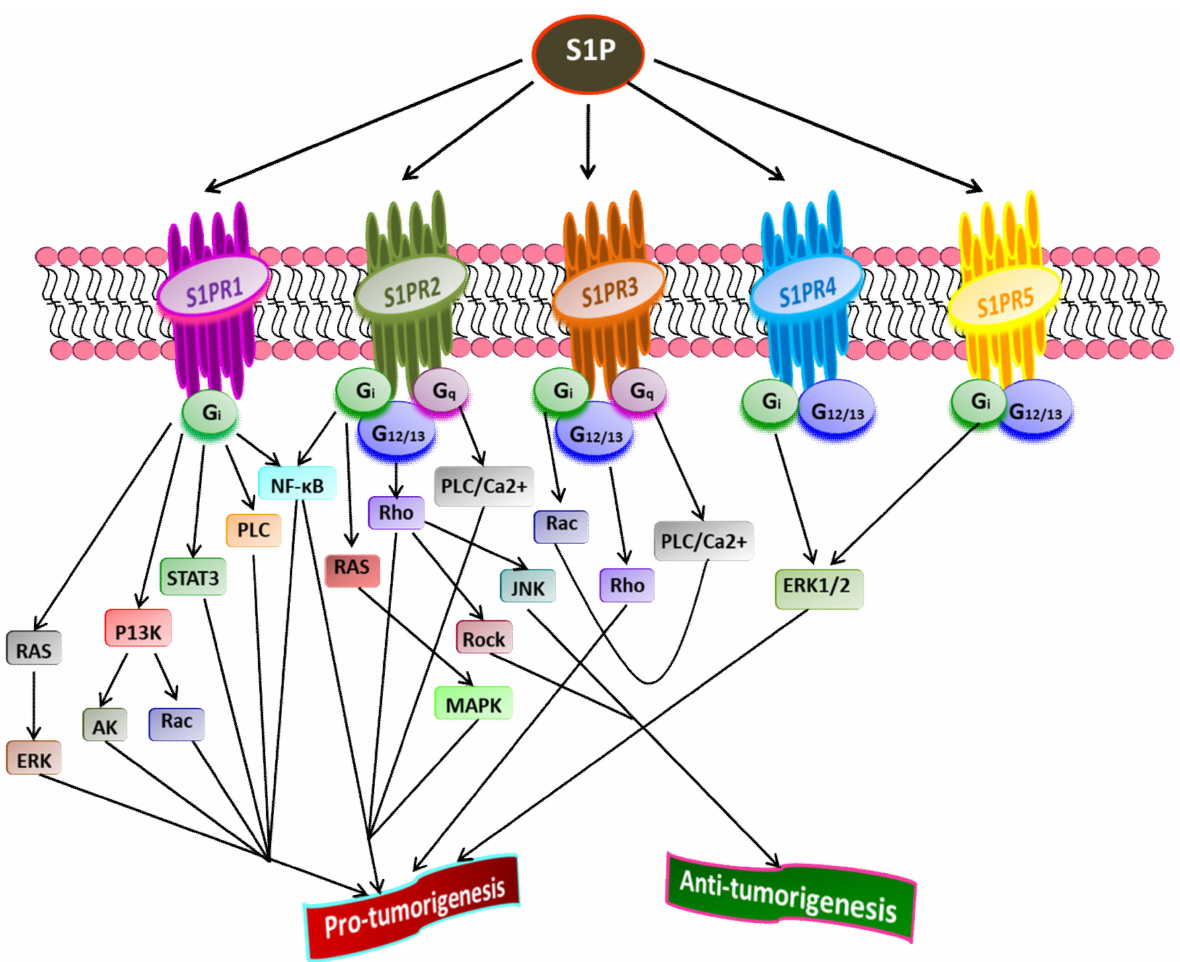
Figure 3. Role of S1P receptors in cancer. Once exported outside the cell, S1P binds and activates S1PR 1-5 that further stimulates receptor-bound G-proteins (G 12/13 , G q , G i ). Subsequently, the activated G-proteins turn on diverse downstream signaling pathways that play a crucial role in tumorigenesis. A cross-talk between various downstream targets of different S1PRs regulating cancer progression is evident (Adapted from